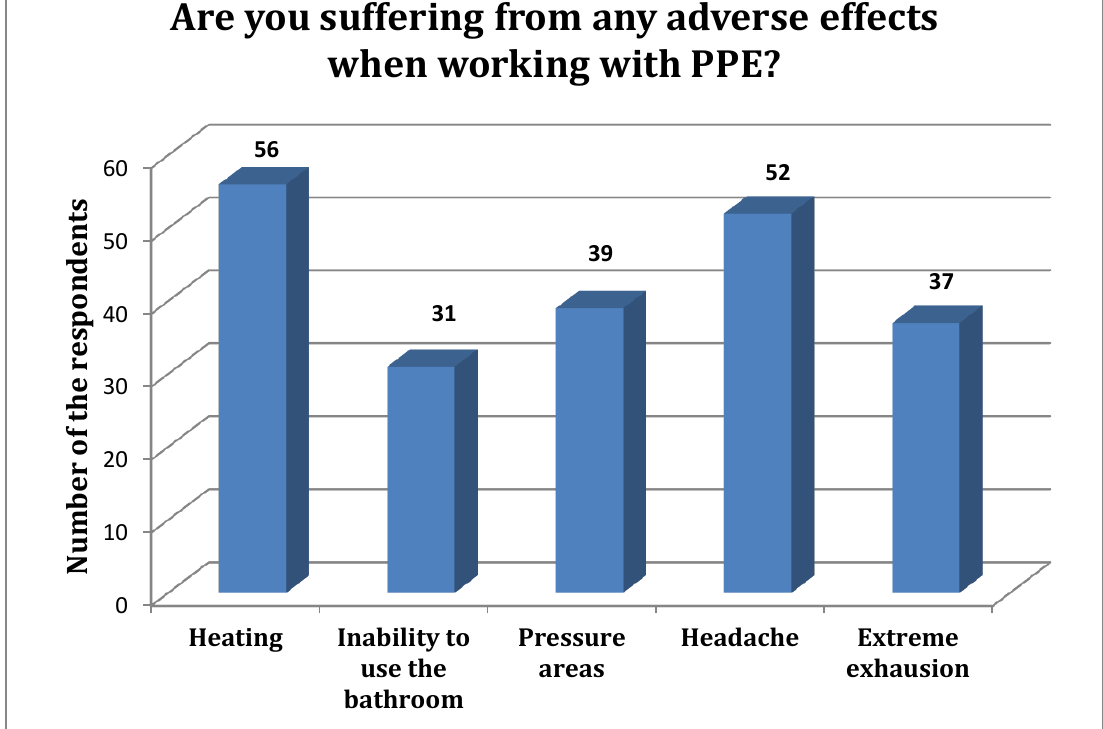
Figure 3. Bar chart showing the significant adverse effects when working with PPE.